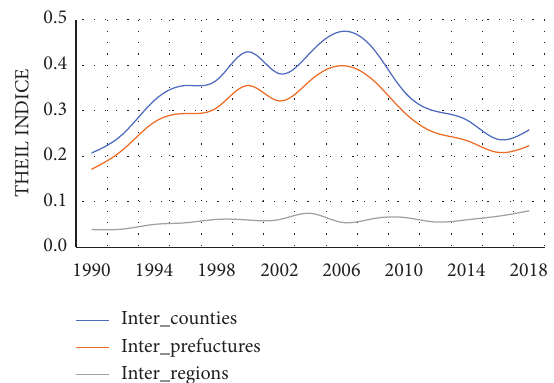
Figure 4: Multiscale regional inequality in Xinjiang,